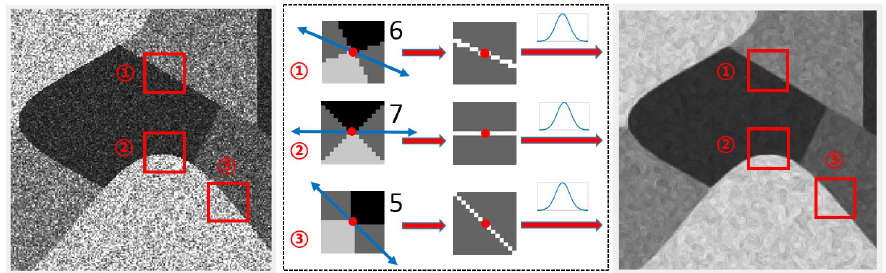
Figure 3. Edge region smoothing